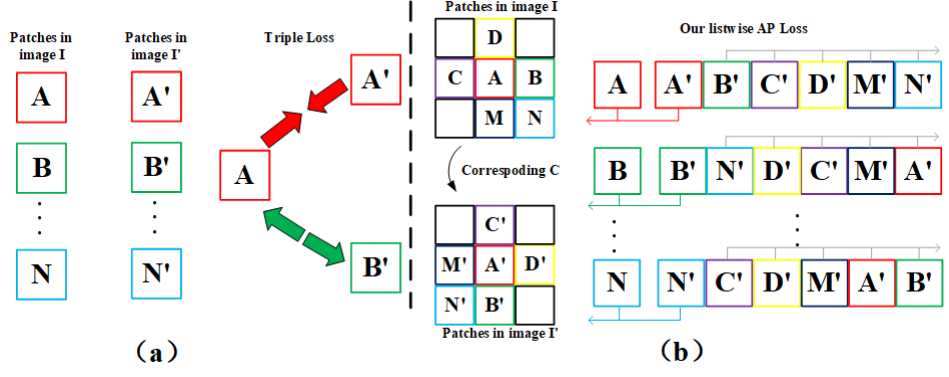
Figure 7. Comparison of descriptor loss. ( a ) is the description of traditional triple loss and ( b ) is the description of our listwise AP